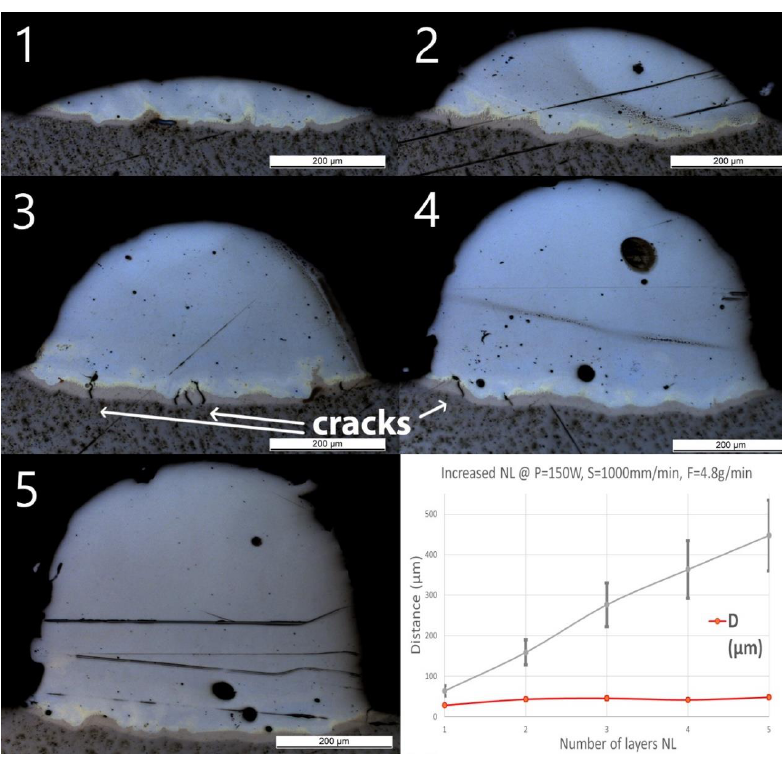
Figure 7. OM images of cross-sections of samples Wall_NL_1 to Wall_NL_5. The last diagram (bottom right) shows the influence of number of layers (NL) on penetration depth (D) and deposition height (H) of the tracks.